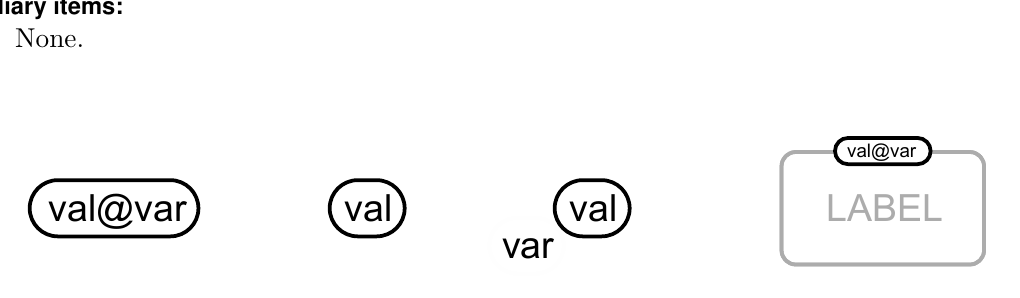
Figure 2.3: The Process Description glyph for state variable , shown with a value and a variable on the far left, with only a value on the middle-left, with an additional label for the variable on the middle-right (discouraged), and decorating a macromolecule (Section 2.4.3) on the far right.